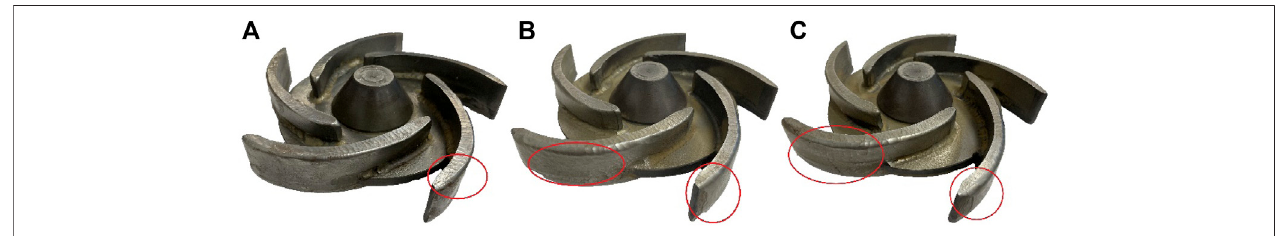
FIGURE 6 | Blade wear under different mass concentration. (A) 15%, (B) 20%, and (C) 30%.